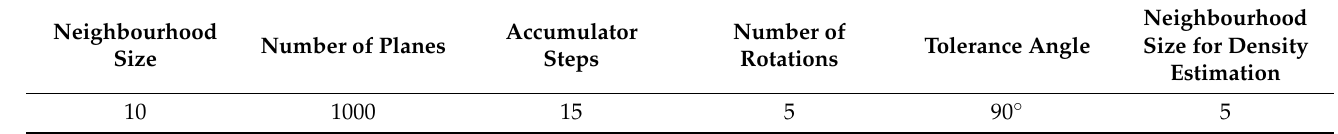
Table 3. Parameters used in the Hough transform